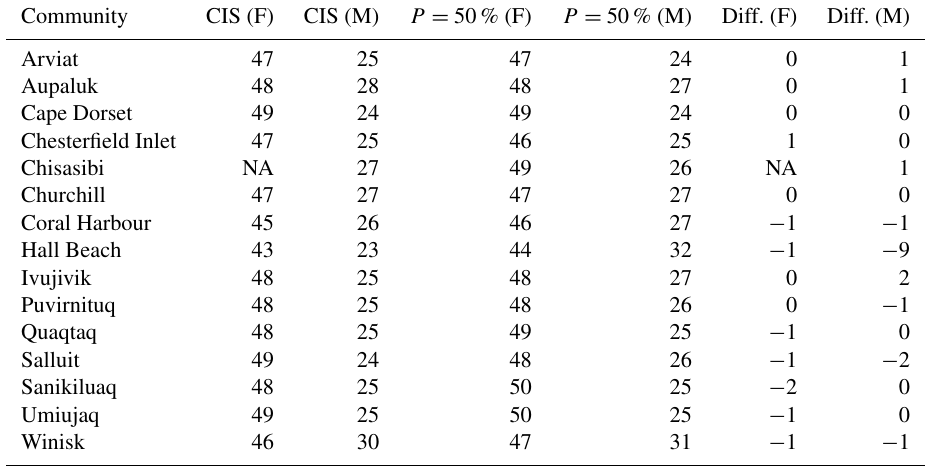
Table 1. Comparison between the CIS atlas and IcePAC p = 50% modelled occurrence weeks for the freeze-up and melt-out events at selected sites in the HBS. (“F” denotes freeze-up, “M” denotes melt-out and “NA” means not available.)